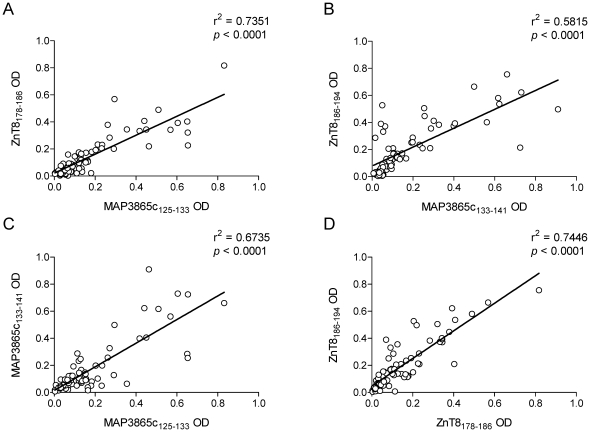
Correlation between titers of MAP3865c- and ZnT8-reactive Abs recognizing different epitopes.Correlations are shown between titers of Abs recognizing (A) MAP3865c125–133 and its homologous ZnT8178–186 epitope; (B) MAP3865c133–141 and its homologous ZnT8186–194 epitope; (C) MAP3865c125–133 and its consecutive MAP3865c133–141 epitope; (D) ZnT8178–186 and its consecutive ZnT8186–194 epitope. Each circle represents the titers of one T1D or healthy donor.